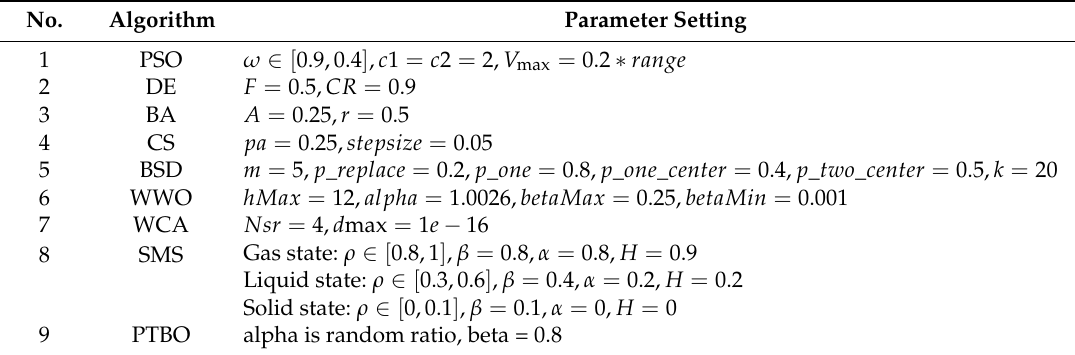
Table 7. The parameter settings of the compared